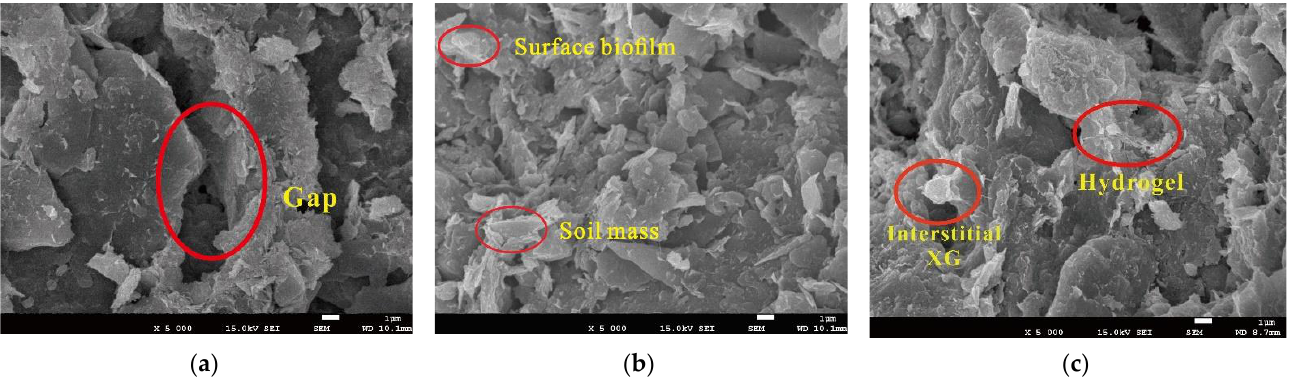
Figure 10. SEM pictures of XG-silt at ×5000 magnification: ( a ) m bp / m s = 0%; ( b ) m bp / m s = 1.0%; ( c ) m bp / m s = 2.0%.